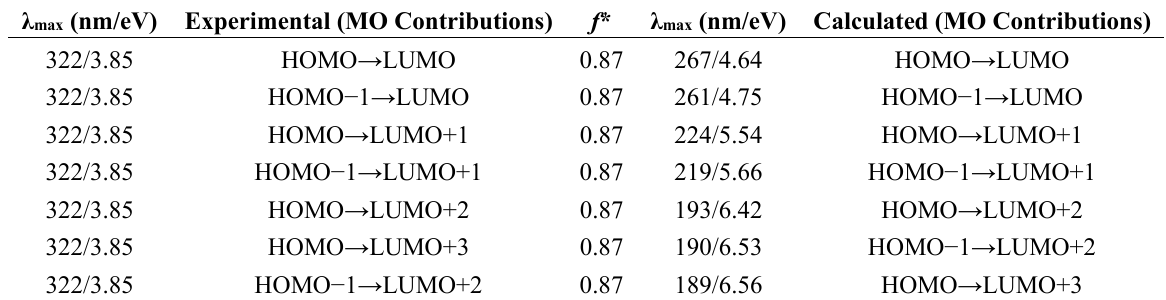
Table 5. Experimental and Calculated Energy of Molecular Orbitals of (I) and Associated